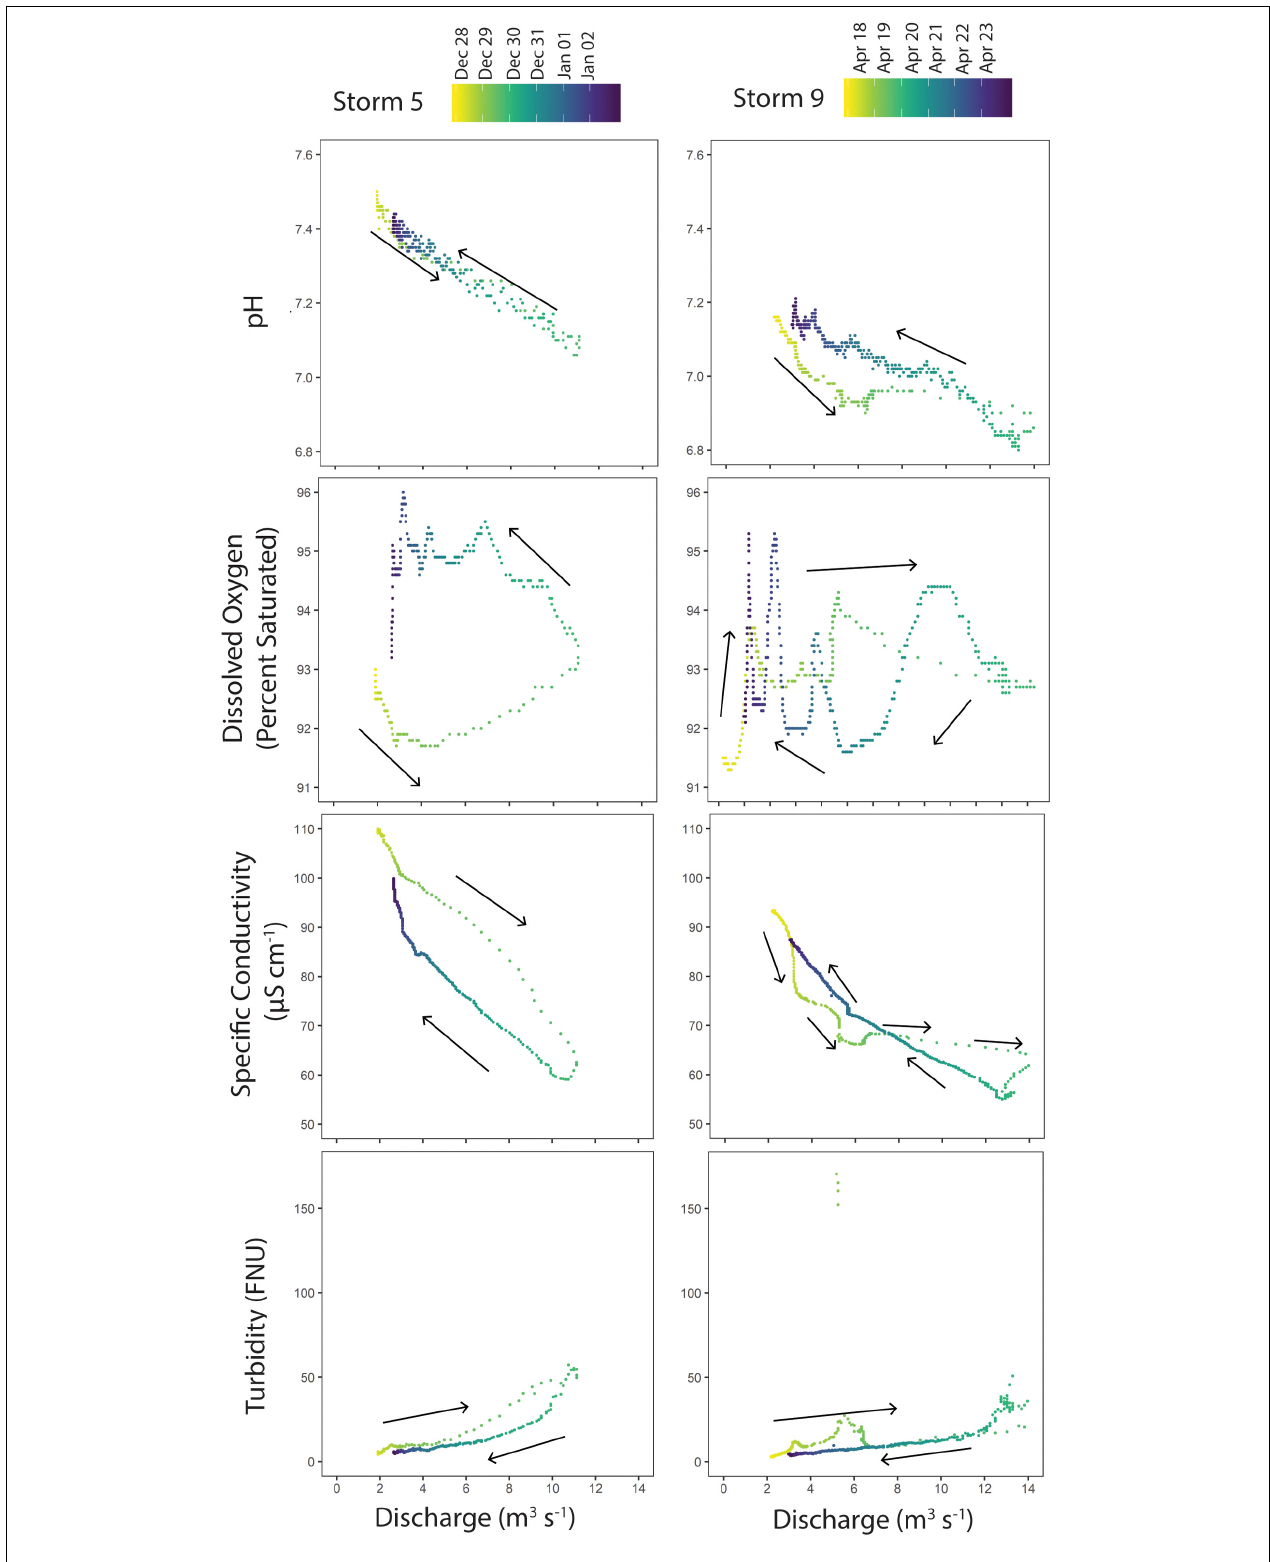
FIGURE 7 | Examples of hysteresis observed for pH, dissolved oxygen, specific conductivity, and turbidity for two storms on the Union River. Two example storms are shown to demonstrate different types of hysteresis seen during the 2017–2018 study.